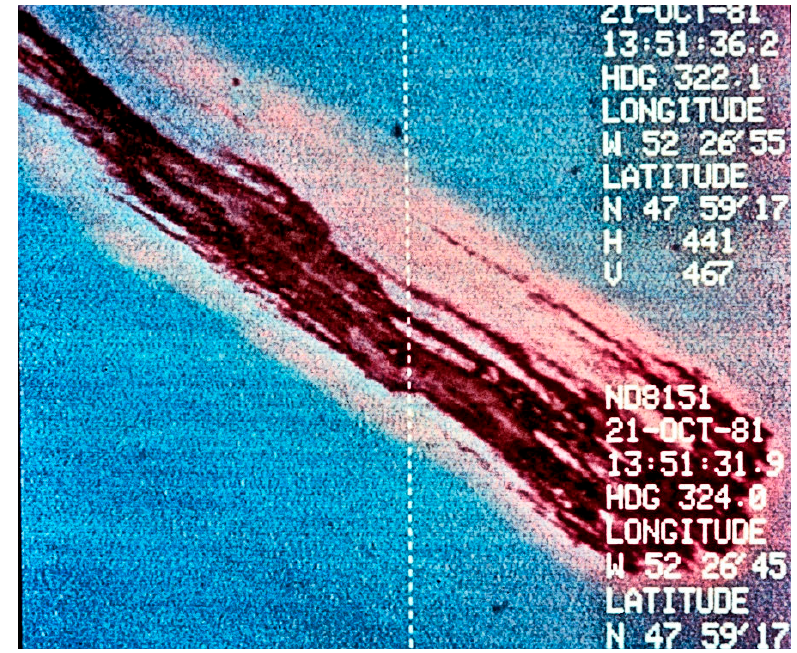
Figure 4. A simultaneous view of a test slick (shown in Figure 3), but using IR. The inclusion of infrared creates additional contrast between the slick and water as well as removing the sun glitter (Photo from Environment Canada).